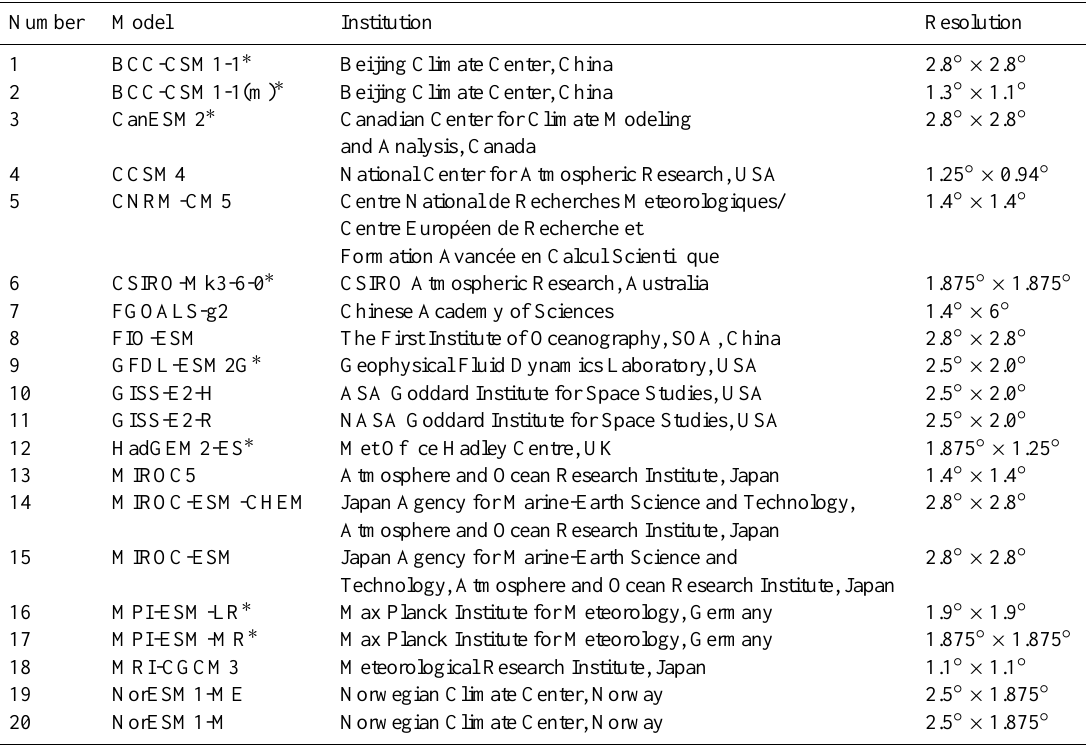
Table 1. Models information used in this